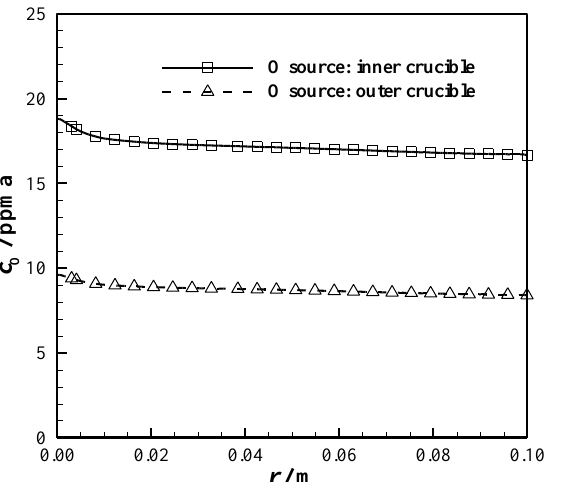
Figure 6. Impacts of the inner crucible and outer crucible on the oxygen distribution (ppma) at the m-c interface.